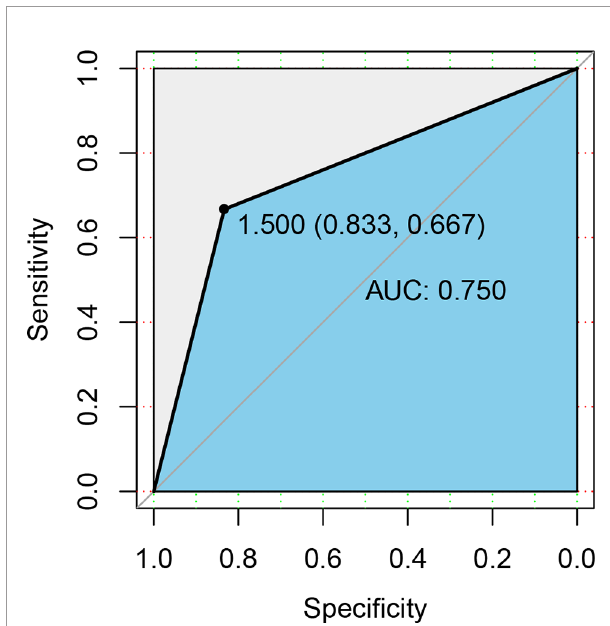
FIGURE 6 | ROC curve differentiation of patients with HSP from healthy groups according to the relative abundance at the genus level. We used ROC analysis to assess how well speci fi c genera of the gut microbiota could discriminate between individuals who experienced disease recurrences and those who did not. The yellow line is the mean ROC curve, and the average area under the ROC curves (AUC) is 0.750, indicating good